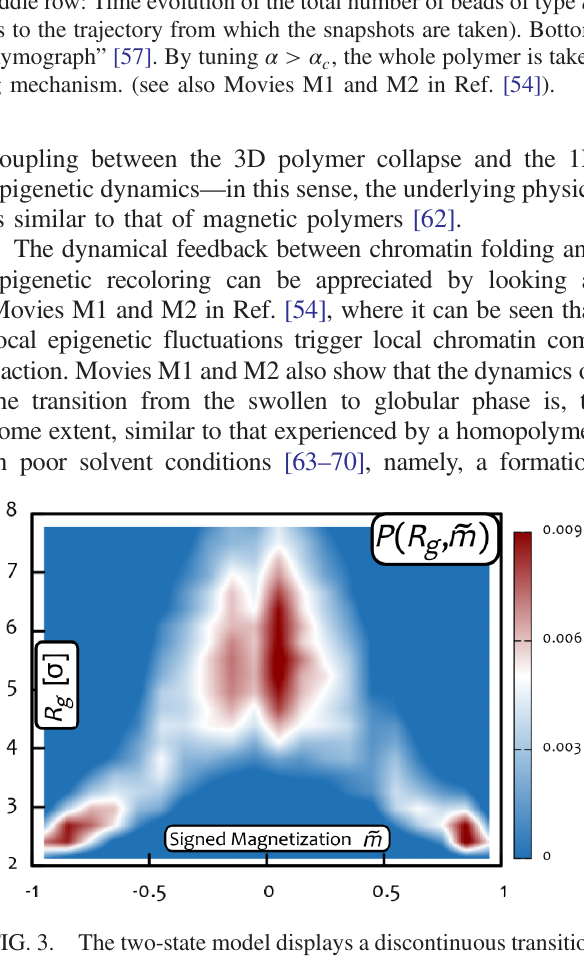
T below B L , the whole polymer is taken c